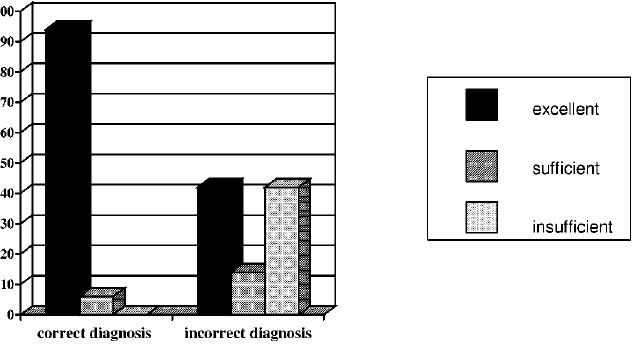
Fig. 6. Relation between frozen section slide quality in diagnostic correct cases versus incorrectly diagnosed cases (in percent of analyzed